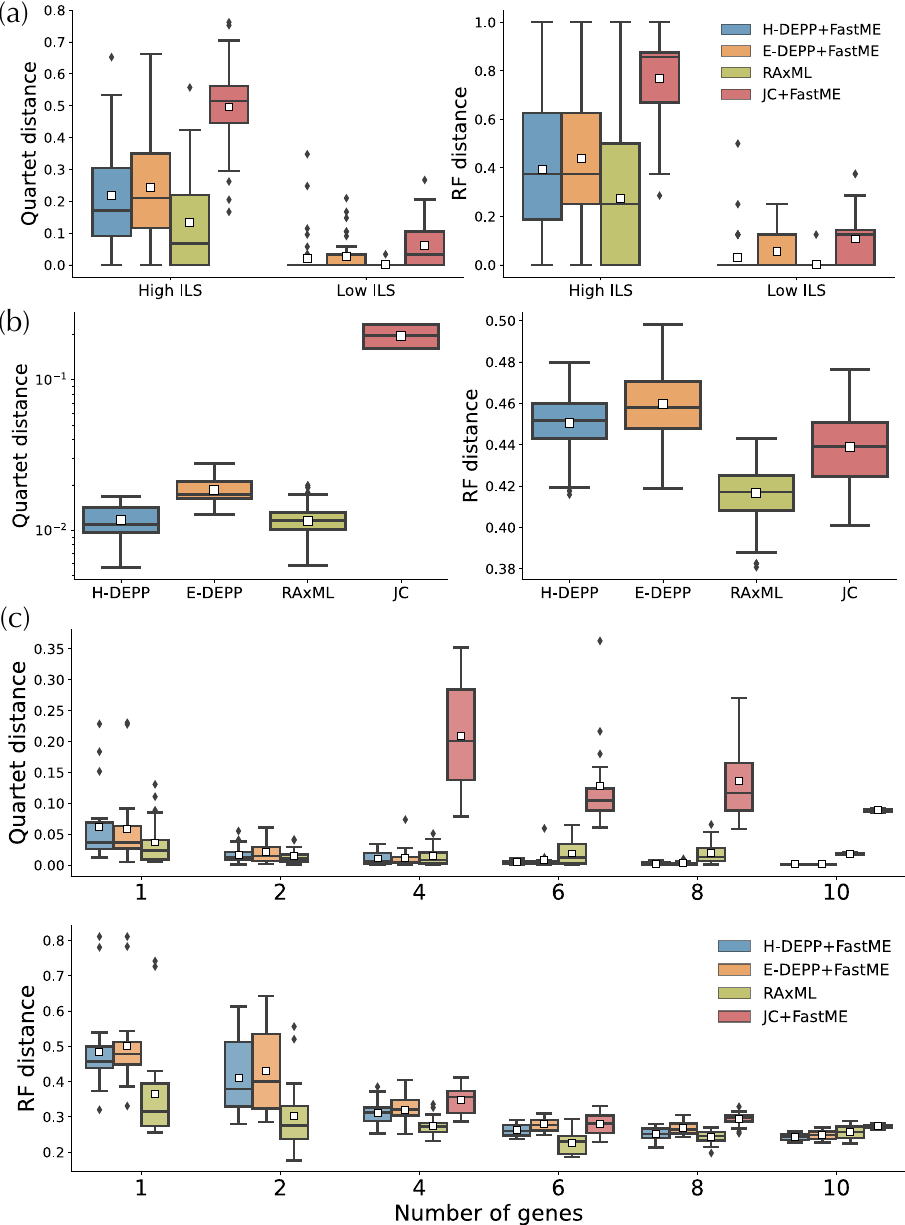
Figure 9. Tree update for ( a ) simulated data ( b ) WoL 16S data ( c ) WoL marker genes data. The white squares in the boxplots represent the average over all